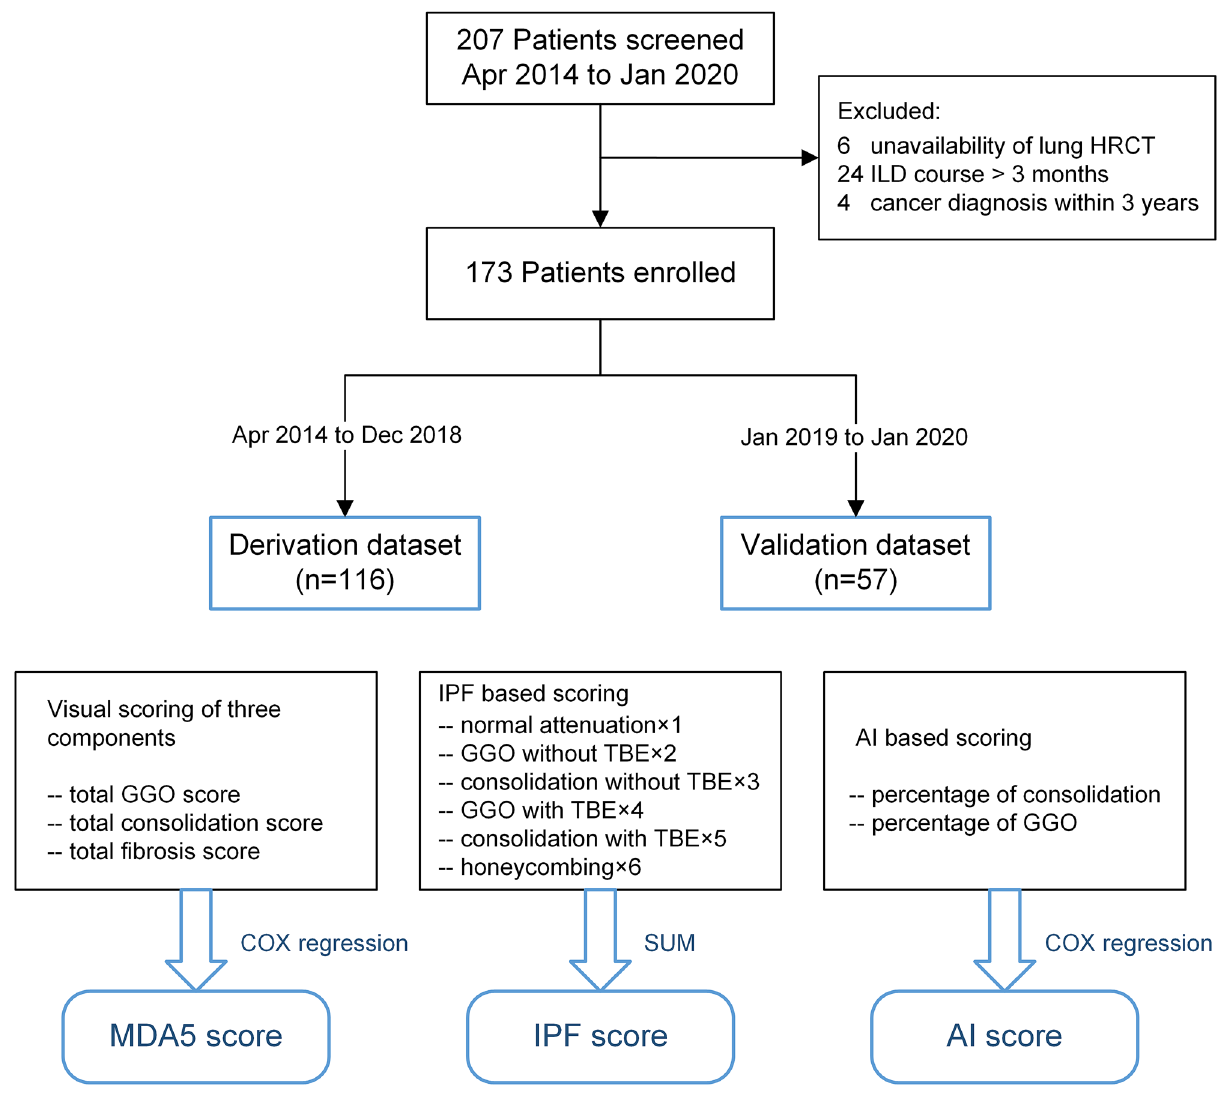
Figure 1. Flow chart of patients and three CT scoring models. MDA5, melanoma differentiation-associated gene 5; HRCT, high-resolution computed tomography; ILD, interstitial lung disease; GGO, ground-glass opacity; TBE, traction bronchiectasis; IPF, idiopathic pulmonary fibrosis; AI, artificial intelligence; DM, score’, by combining defined prognostic factors weighted by their β coefficients was finally generated: total GGO score + 2*total consolidation score. ROC curve analysis indicated that the optimal cutoff value for ‘MDA5 score’ was 18, which could efficiently predict the six-month all-cause mortality in the derivation dataset (sensitivity 70.2%; specificity 82.6%) and the validation dataset (sensitivity 85.7%; specificity 63.9%). The prediction accuracy of ‘MDA5 score’ calculated by AUC was 0.85 (95%CI 0.78–0.91) for the derivation dataset and 0.87 (95%CI 0.78–0.96) for the validation data- set, far ahead of the ‘IPF score’, which was 0.81 (95%CI 0.73–0.89) for the derivation dataset and 0.79 (95%CI 0.68–0.91) for the validation dataset. Additionally, The Kaplan–Meier survival plots of patients in both datasets presented significant difference between the high-risk (‘MDA5 score’ > 18) and low-risk (‘MDA5 score’ ≤ 18) groups (Figs. 1, 2). The mortality of high-risk patients was 73.3% in the derivation dataset and 58.1% in the validation dataset; while the mortality of low-risk patients was 19.7% in the derivation dataset and 11.5% in the validation dataset. ‘AI score’: an AI algorithm‑based quantitative analysis. The redundancy of the baseline fibrosis component in terms of outcome prediction made pneumonia-trained AI algorithm plausible for our MDA5 + DM-ILD patients’ CT quantitative analysis (Fig. 3A). Percentage of consolidation was determined as the only significant predictor for the overall survival in the final multivariable COX model ( p < 0.001) (Table 2). Thus, the percentage of consolidation was defined to represent ‘AI score’. Interestingly, the radar charts in Fig. 3B showed